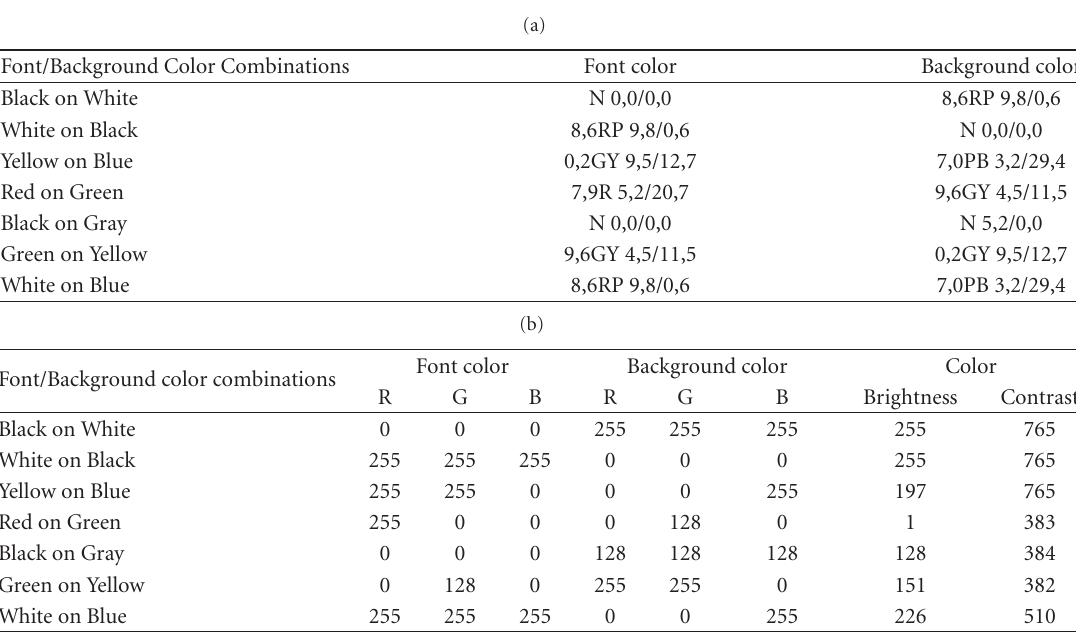
Table 1: The font/background color combinations used in this study: (a) in the Munsell perceptual color space and (b) in RGB along with the corresponding brightness/contrast